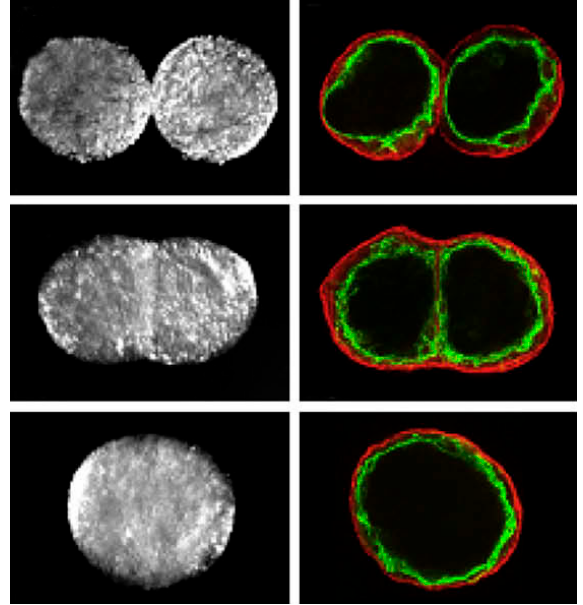
Figure 6. Bioprinting of segments of intraorgan branched vascular tree using uni-lumenal vascular tissue spheroids in hanging drop after tissue fusion, courtesy of